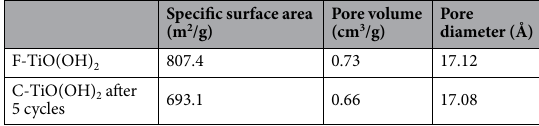
Table 1. BET characteristics of F-TiO(OH) 2 and C-TiO(OH) 2